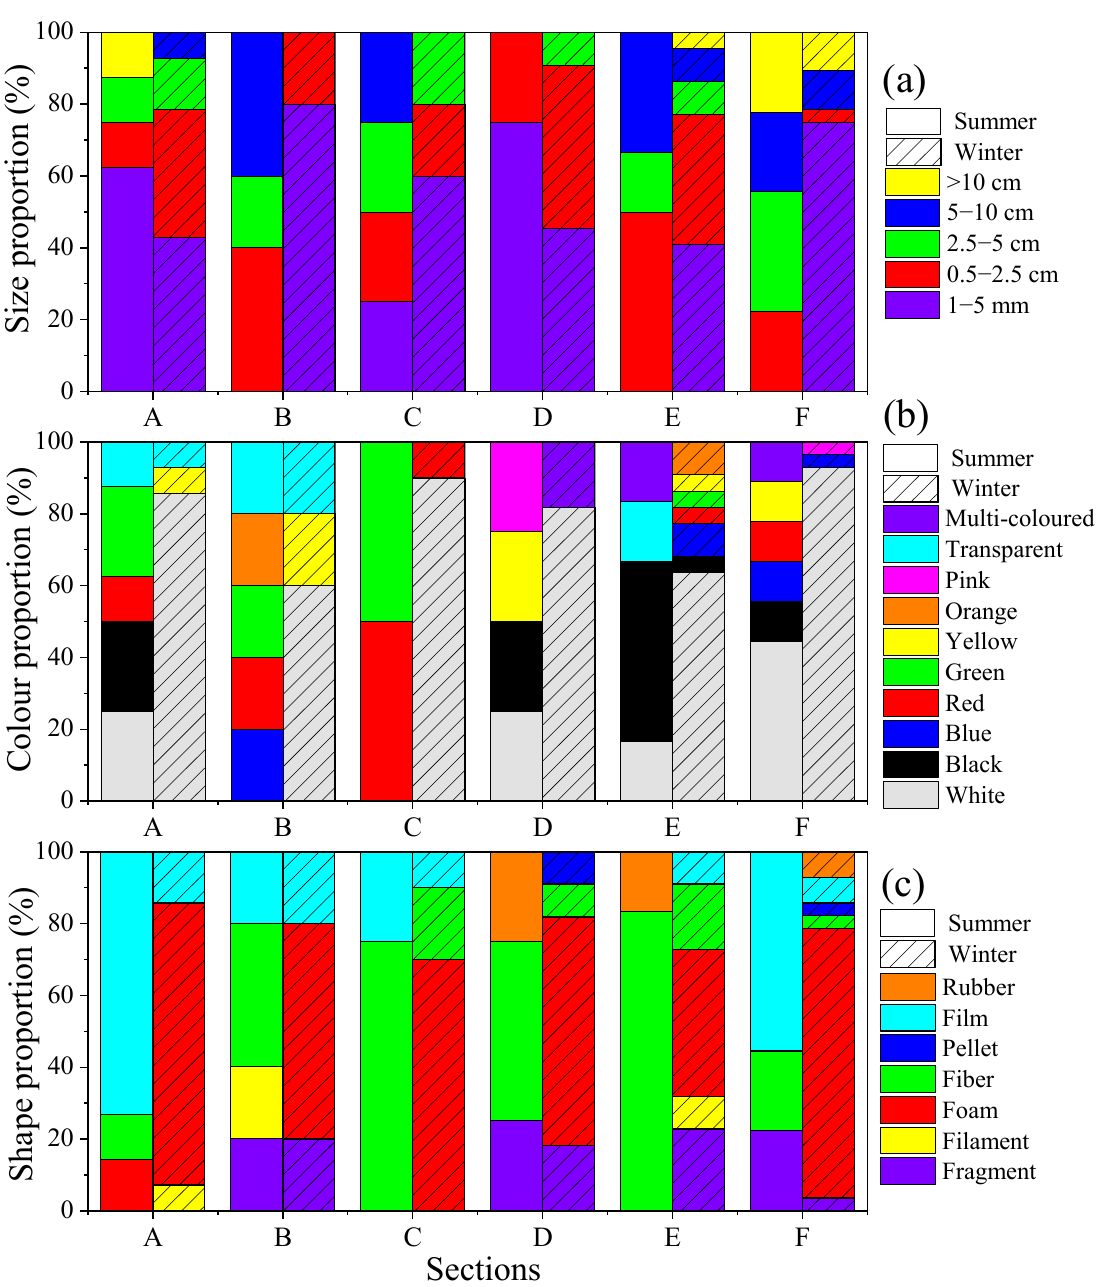
Figure 4. Seasonal size proportion ( a ), colour proportion ( b ), and shape proportion( c ) of plastic debris on the YPB.